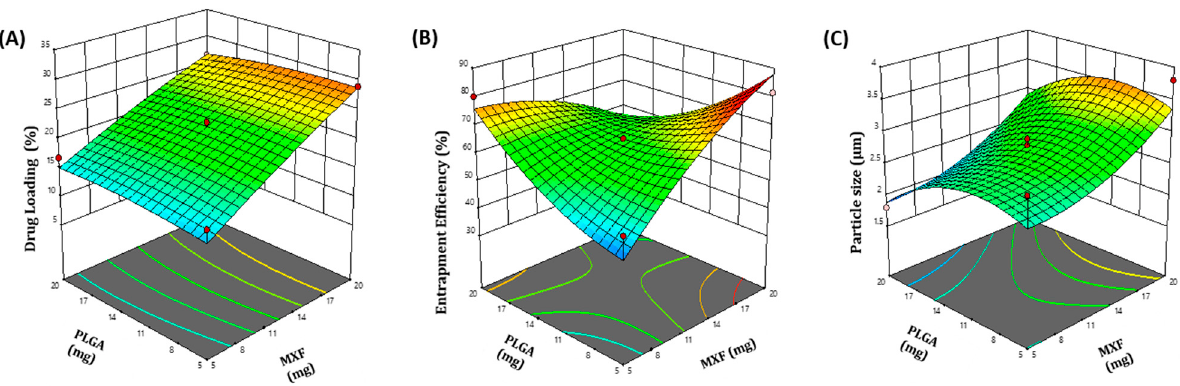
Figure 1. Three-dimensional surface response plots of the estimated effects. ( A ) The effect of drug concentration (X 1 ) and polymer content (X 2 ) on percent drug loading (R 1 ). ( B ) The effect of drug concentration (X 1 ) and polymer content (X 2 ) on percent entrapment efficiency (R 2 ). ( C ) The effect of drug concentration (X 1 ) and polymer content (X 2 ) on particle size (R 3 ).